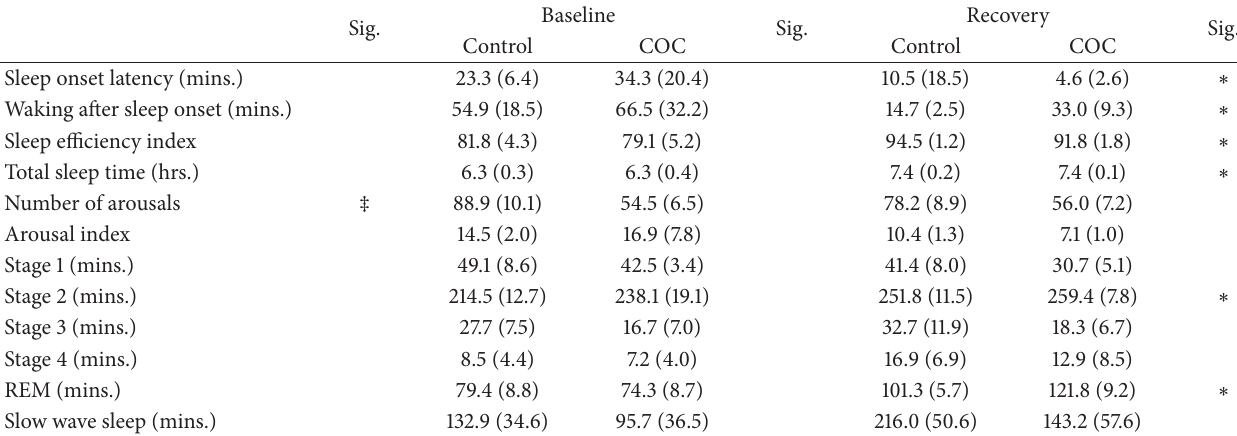
Table 2: Polysomnographic assessments of sleep control versus all cocaine-dependent (COC) participants data are displayed as mean (Standard Deviation). Baseline Sig. Sig. Sig. Control COC Control COC Sleep onset latency (mins.) ∗ Waking after sleep onset